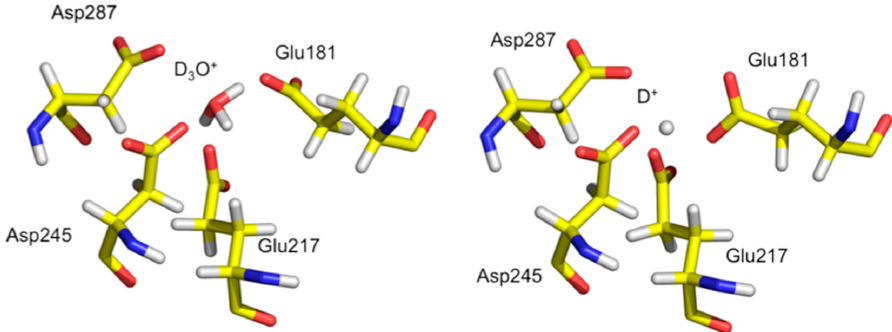
Figure 8. Atomic details of metal binding site M1 using neutrons at two different pHs. ( Left ) Coordination of hydronium ion D 3 O + located in metal site M1 at pH 7.7 (from PDB ID 3kcj); ( Right ) Coordination of proton D + located in metal site M1 at pH 5.9 (from PDB ID 3qza).